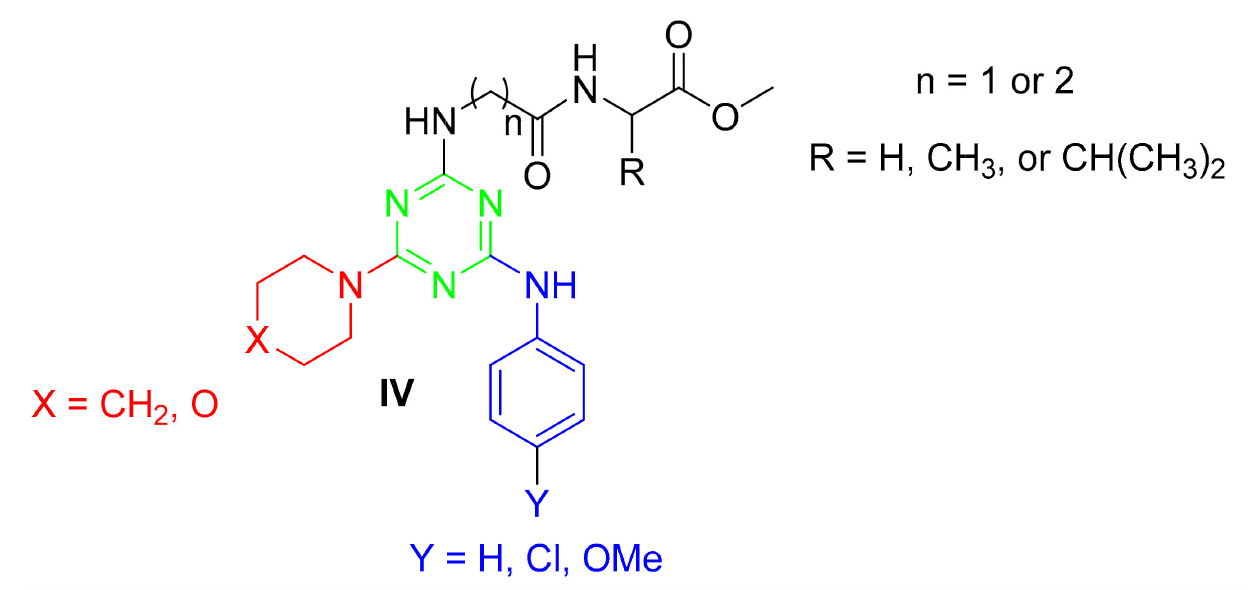
Figure 2. The target s -triazinyl dipeptide